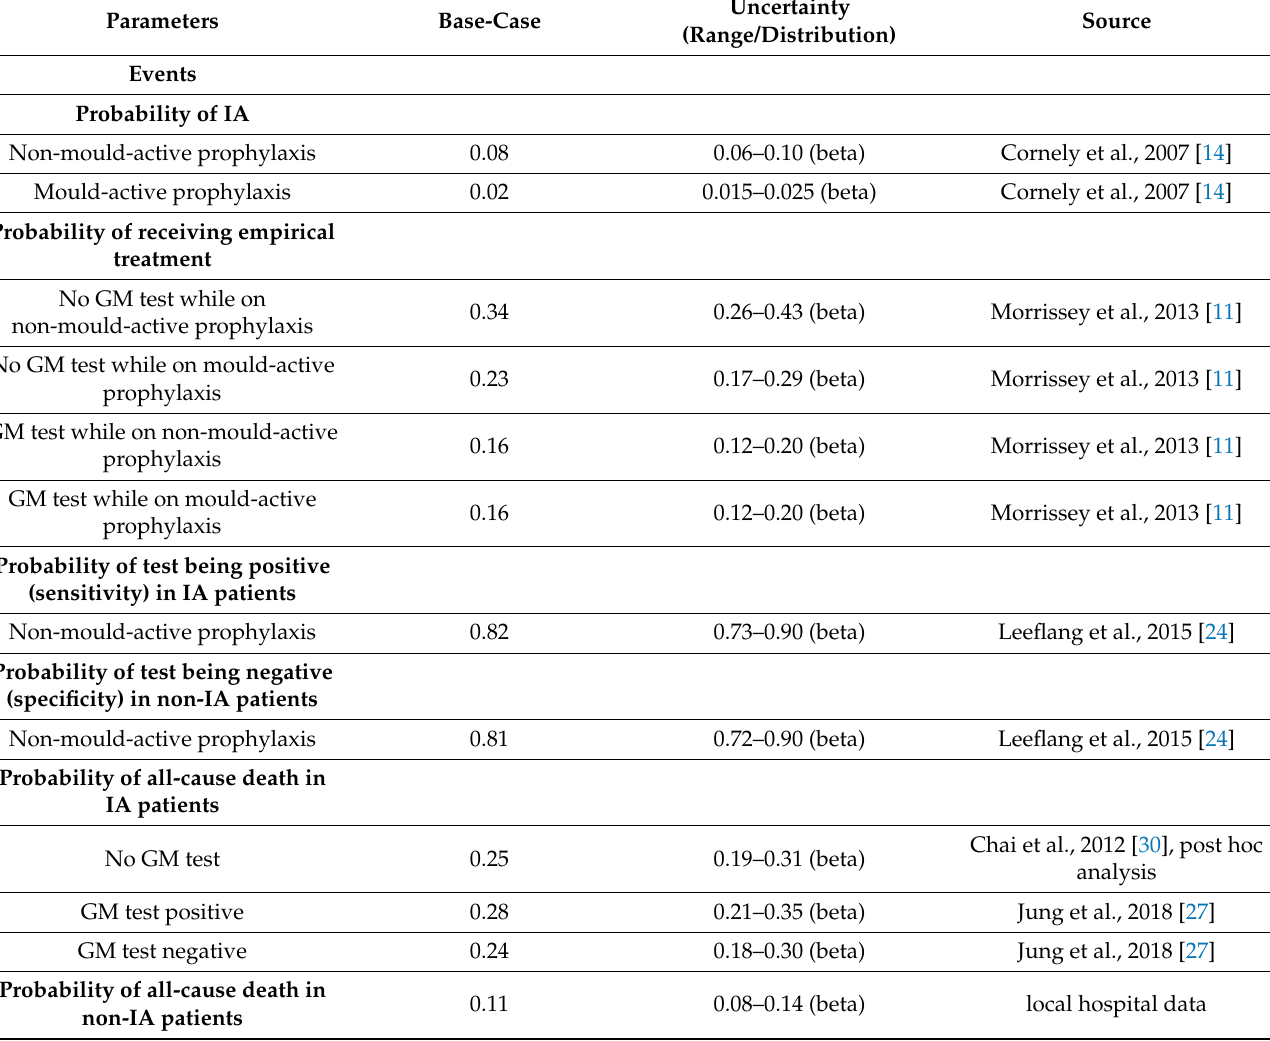
Table 1. Model input